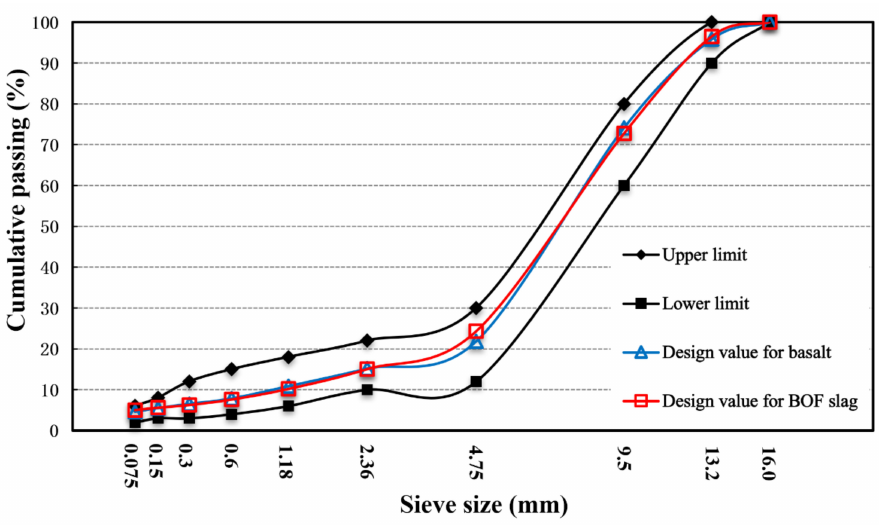
Figure 1. Gradation curves of basalt and BOF slag.